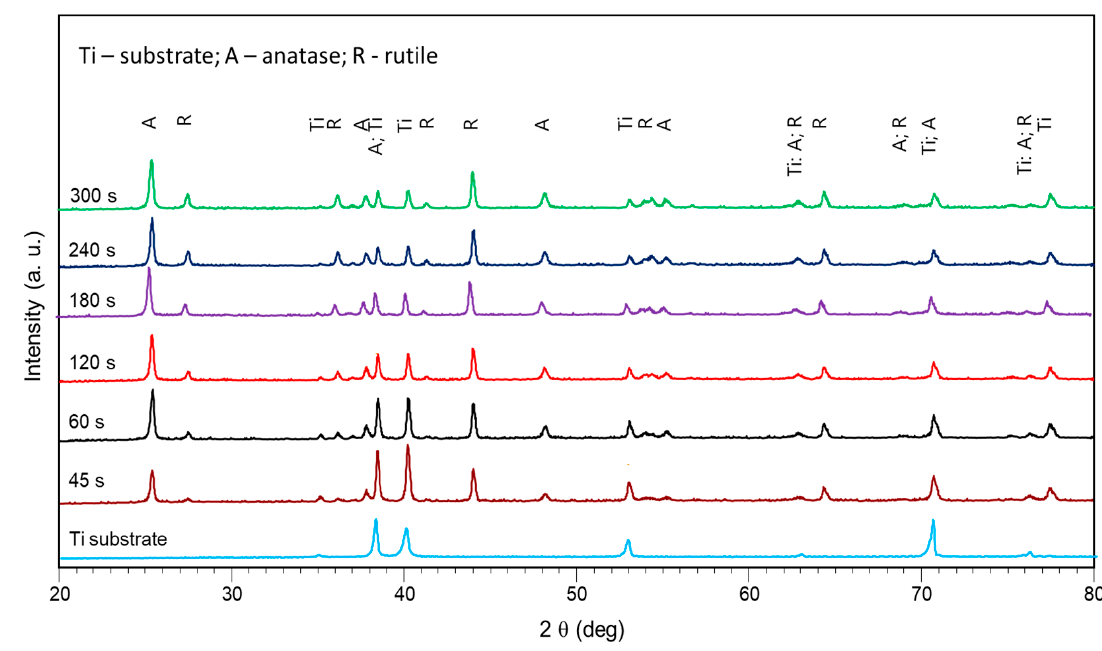
Figure 3. Surface morphology, coating cross-sections, and corresponding pore size distributions (with lognormal distribution fit) for the different PEO treatment times: ( a , b ) 180 s; ( c , d ) 240 s; ( e , f ) 300 s.